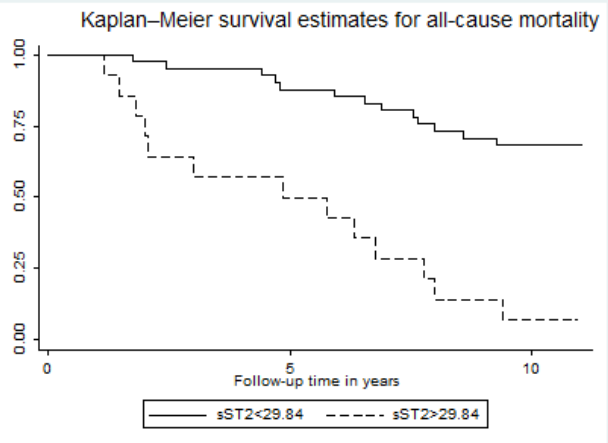
Figure 3. Kaplan – Meyer survival estimates for all-cause mortality in stable COPD stratified according to circulating sST2 levels. Circulating sST2 was measured as described in the Methods section. Survival in groups according to baseline sST2 is depicted. The group with circulating sST2 above the cut-off is indicated by the dotted line, and the full line indicates the group with sST2 below the cut-off.